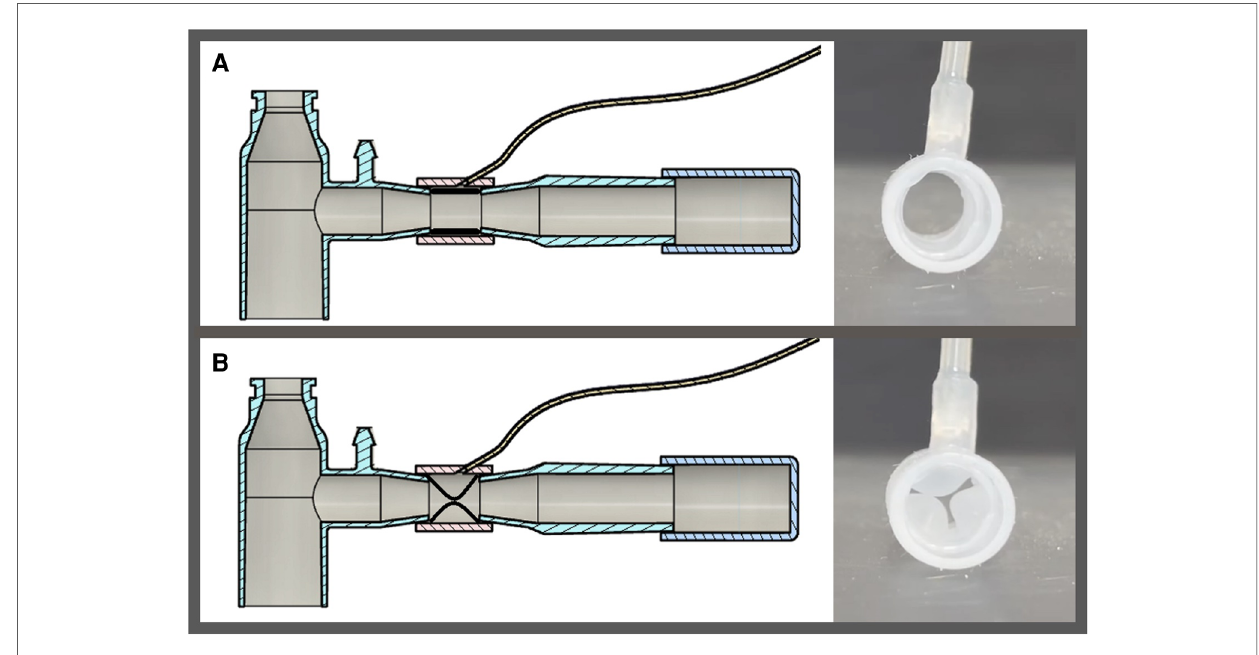
FIGURE 1 Schematic presentation of system for asymmetric fl ow regulation (SAFR). Each of the two SAFR ’ s limbs contains an internal balloon whose degree of in fl ation regulates local gas fl ow and thus tidal volume delivered to each individual lung. The balloons are: ( A ) de fl ated at the baseline state, and ( B ) in fl ated during the inspiratory gas fl